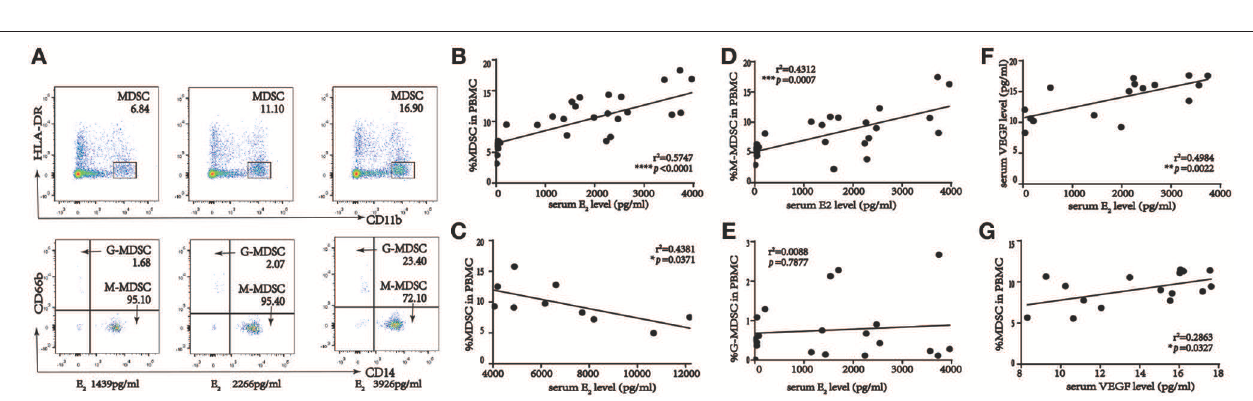
FIGURE 2 | Percent of MDSC in the course of IVF patients, and statistical analysis of correlation among percentage of MDSC in PBMC, serum E 2 and VEGF level in IVF patients. (A) Gating strategy of MDSC by flow cytometric analysis. HLA-DR − / low and CD11b + cells were first gated from live PBMC for MDSC. The expression of cell surface markers CD14 + and CD66b + on this population was evaluated further for M-MDSC and G-MDSC subsequently. (B) Correlation between percentage of MDSC in PBMC and serum E 2 level when serum E 2 level < 4,000 pg/ml ( r 2 = 0.5747, **** p < 0.0001, n = 40). (C) Correlation between percentage of MDSC in PBMC and serum E 2 level when serum E 2 level more than 4,000 pg/ml ( r 2 = 0.4381, * p = 0.0371, n = 10). (D) Correlation between percentage of M-MDSC in PBMC and serum E 2 level when serum E 2 level < 4,000 pg/ml ( r 2 = 0.4312, *** p = 0.0007, n = 40). (E) Correlation between percentage of G-MDSC in PBMC and serum E 2 level when serum E 2 level < 4,000 pg/ml ( r 2 = 0.0088, p = 0.7877, n = 40). (F) Correlation between serum VEGF and E 2 level when serum E 2 level < 4,000 pg/ml ( r 2 = 0.4984, ** p = 0.0022, n = 16). (G) Correlation between percentage of MDSC in PBMC and serum VEGF level when serum E 2 level < 4,000 pg/ml ( r 2 = 0.2863, * p = 0.0327, n =